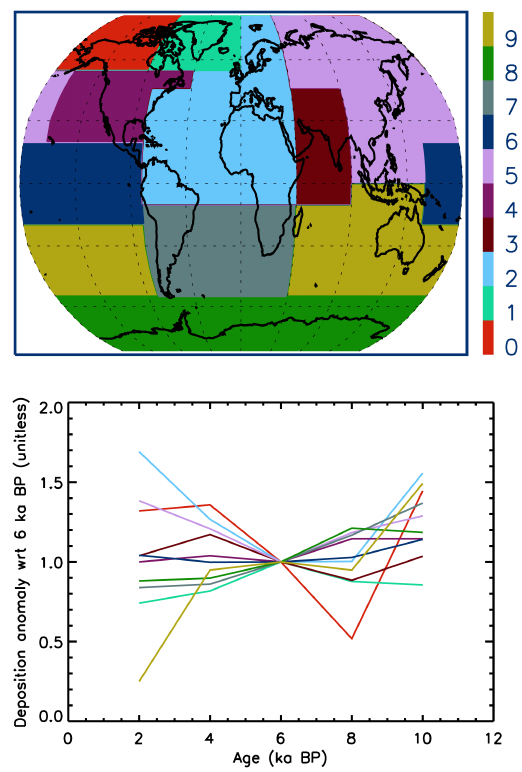
Figure 4. Upper panel: subdivision of the globe into different ar- eas, based on the spatial distribution of data in this compilation (0: Alaska; 1: Greenland; 2: northern Africa and North Atlantic; 3: Ara- bian Sea; 4: North America; 5: eastern Asia and North Pacific; 6: equatorial Pacific; 7: South Atlantic; 8: Antarctica; 9: Australia). Bottom panel: time series (at a 2kyr interval) of the dust deposition anomaly with respect to (wrt) 6kaBP for the different areas, as es- timated from the observations. Color-coding of the different areas is consistent between upper and lower